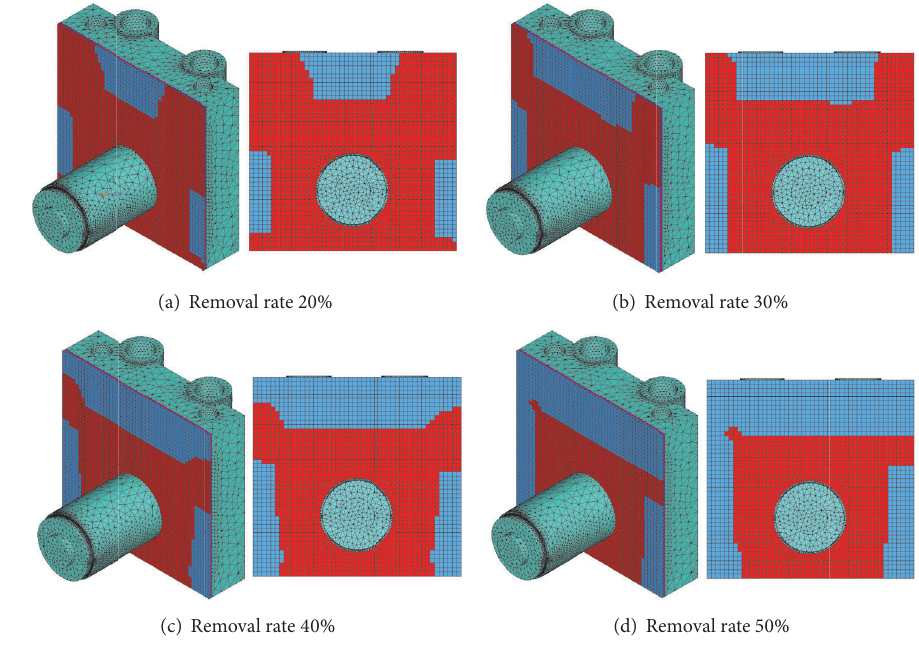
Figure 16: Optimization result with material.